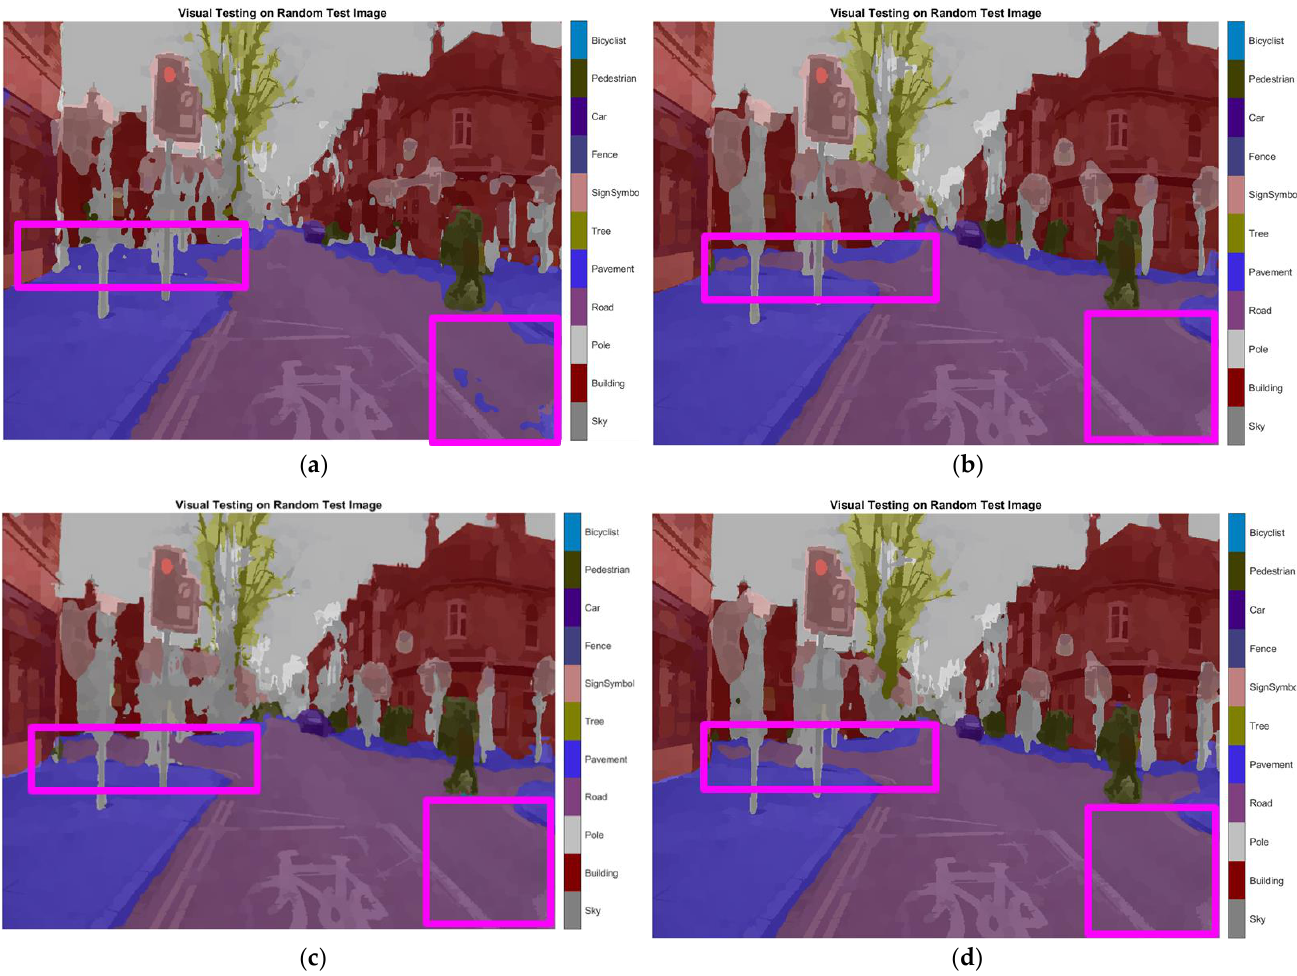
Figure 8. Visual Analysis of a Tested Image. ( a ) ResNet-DeepLabV3+, ( b ) RGSNet-DeepLab, ( c ) MobileNet-DeepLab, ( d ) Customized Decoder-DeepLab. The image portions highlighted with pink boxes over the tested image show that ResNet-DeepLabV3+ misclassified road (class) pixels as pavement, whereas our proposed variants classified the pixels accurately in the corresponding regions. Table 7 shows some more visual results of semantic segmentation over the tested images. Table 7. Visual Semantic Segmentation Results.